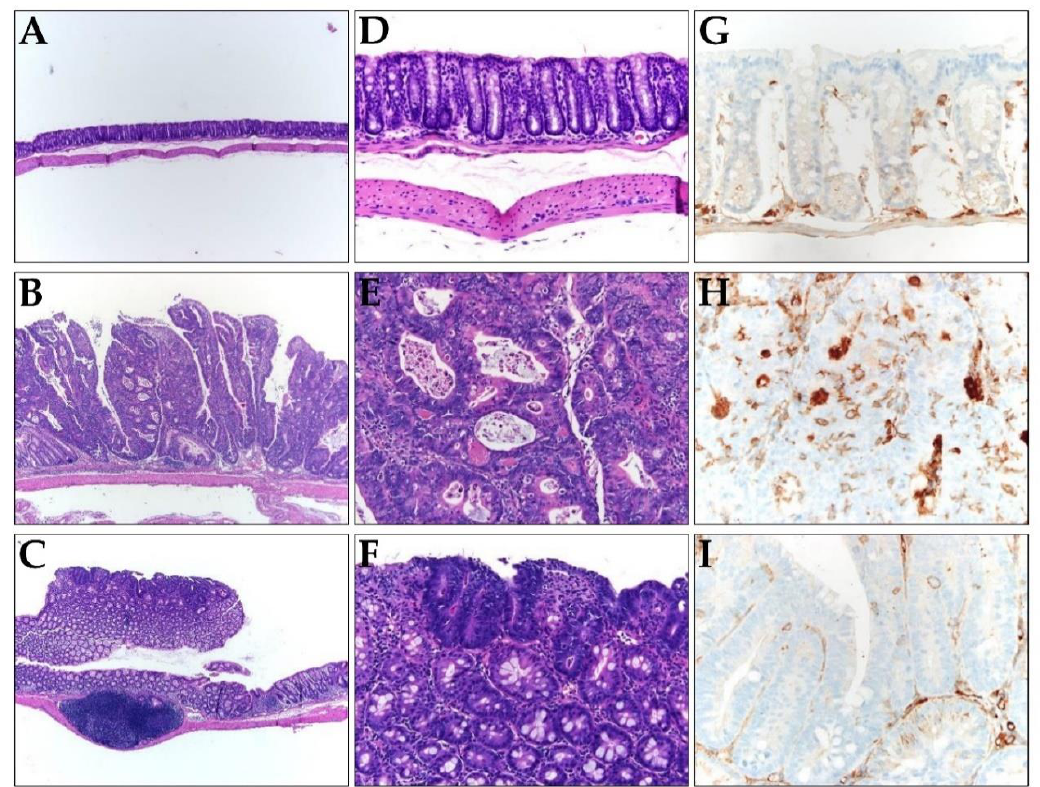
Figure 5. ( A – F ) Representative histology images of colons resected from ( A , D ) the control, ( B , E ) AOM/DSS, and ( C,F ) AOM/DSS + ASCs groups. ( A – C ) Low-power view (×100) of colon tissues stained with hematoxylin and eosin ( H , E ), showing most tumors are bigger in mice from ( B ) the AOM/DSS group compared to the small and superficial tumors in mice from ( C ) the AOM/DSS + ASCs group. ( D – F ) Higher magnification (×200) of H&E staining, showing ( D ) normal mucosa, ( E ) AOM/DSS-induced moderately differentiated adenocarcinoma, and ( F ) the tumor in AOM/DSS + ASCs group, which is similar to that of the AOM/DSS group. ( G – I ) The immunohistochemical staining of CD133 in ( G ) the control, ( H ) AOM/DSS, and ( I ) AOM/DSS + ASCs (×400). ( G ) No CD133 expression in the normal mucosa. ( H ) Strong expression of CD133 along the lumen structure of the AOM/DSS-induced tumor glands. ( I ) Very rare and focal CD133 positivity in the tumor from the AOM/DSS + ASCs group.